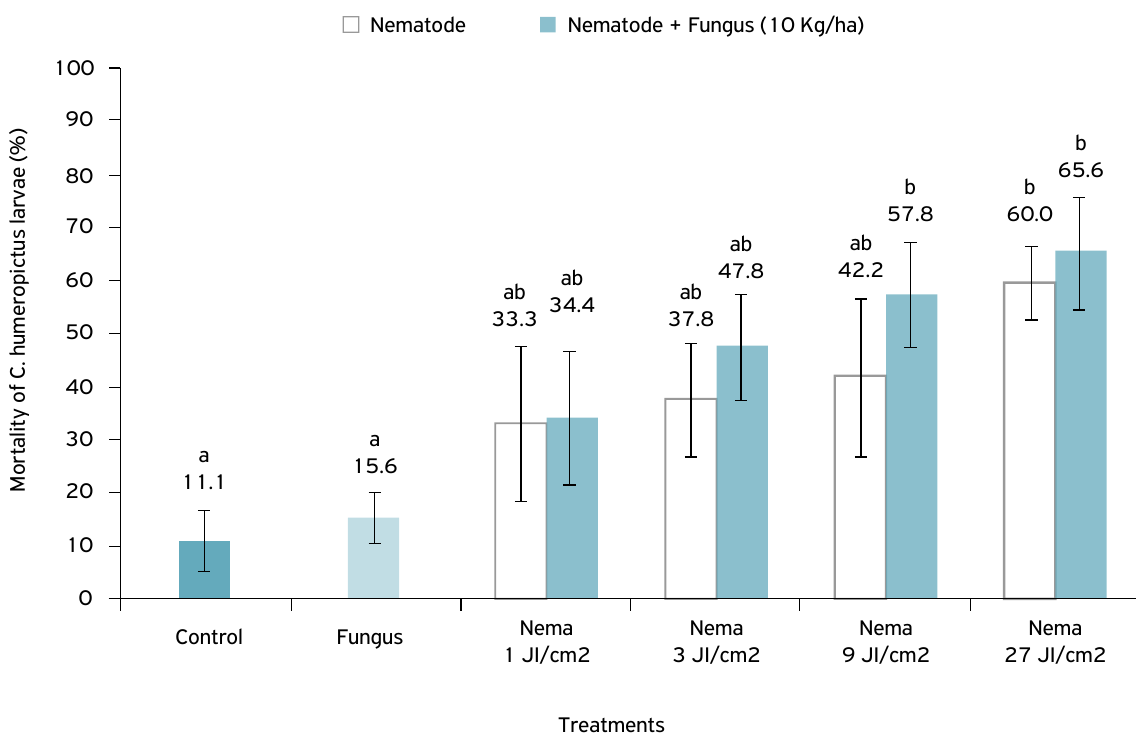
Figure 3. Mortality of Conotrachelus humeropictus larvae exposed to the Steinernema brazilense nematode at doses of 1, 3, 9